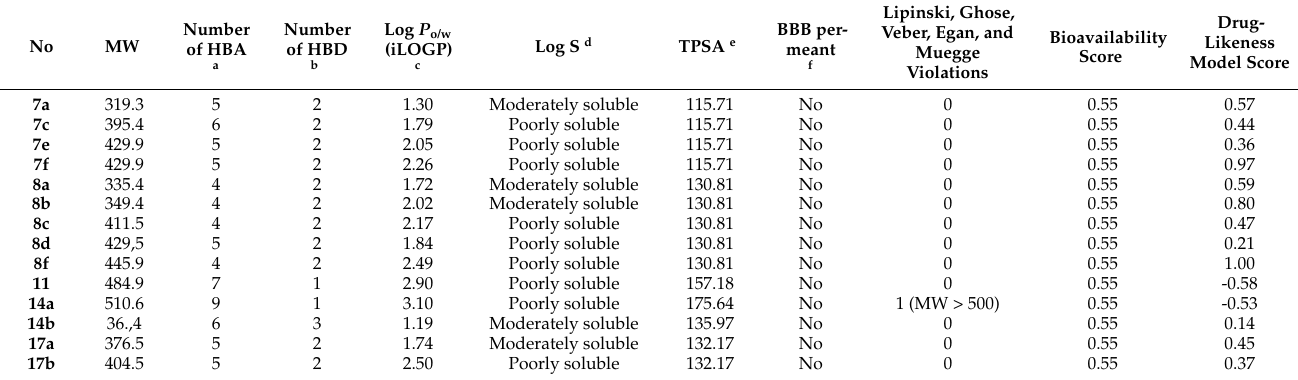
Table 3. Drug likeness predictions and Physicochemical-Pharmacokinetic/ADME properties of tested compounds.